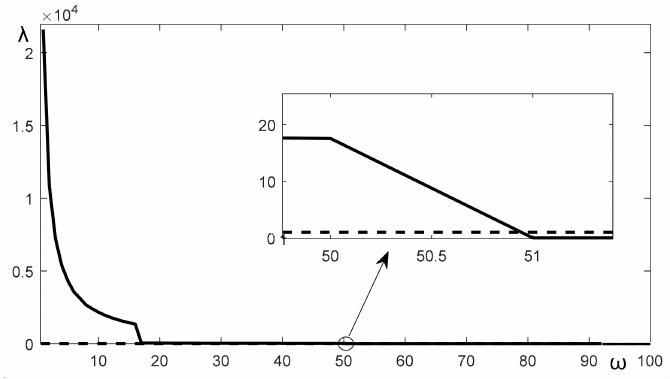
Figure 5. λ with respect to ω